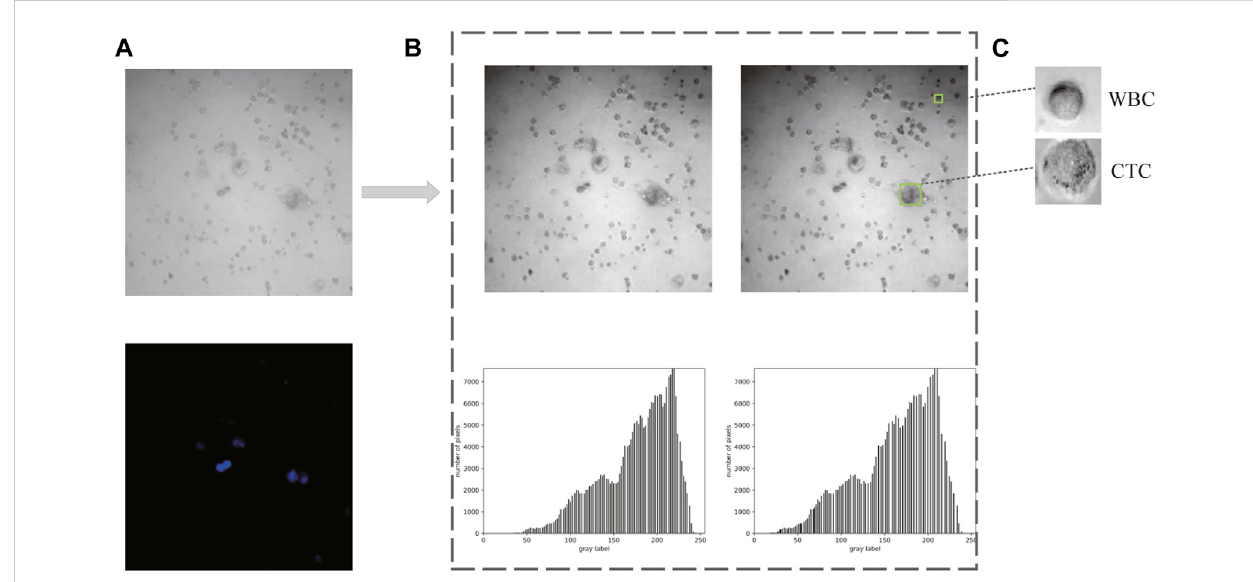
FIGURE 5 Data acquisition and preprocessing. (A) Raw images obtained from confocal microscope. (B) Preprocessed images and the corresponding histograms. (C) Cropped images with single cell for dataset